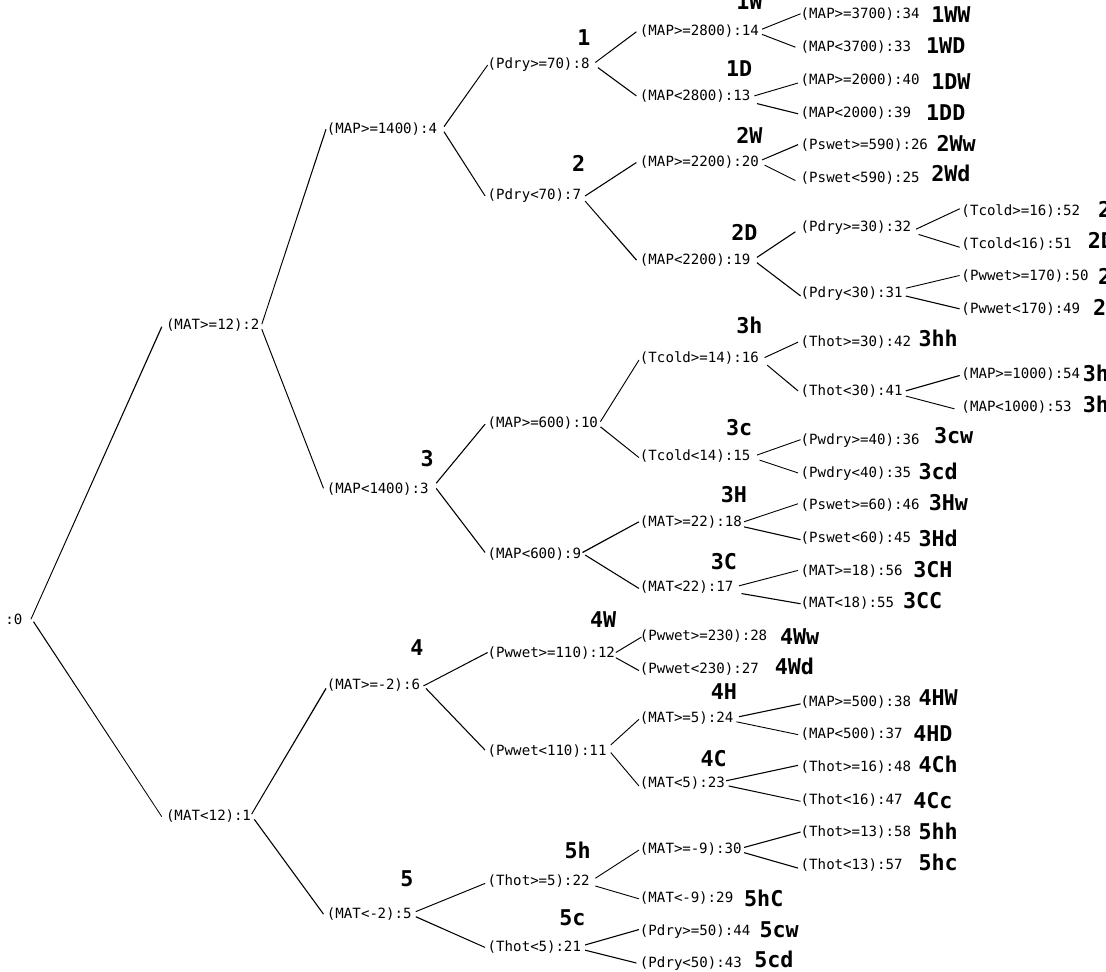
Fig. 1. Binary tree representation of the MRT climate classification rules. Climate variable names are given in Table 1. At each node, the decision rule is listed preceding the colon, while the order in which binary split was made is denoted by the integer value following the colon. Class names are given in bold. The 5 class level is assigned a number from 1–5. The 13 class and 30 class levels are denoted by adding letters to the numbers. If the rule immediately preceding the terminal node involves a precipitation variable, aW, w, D, or d is added, where the W or w indicates wetter conditions and the D or d indicates drier conditions. If the preceding rule involves a temperature variable, aH, h, C, or c is added, where the H or h indicates hotter conditions and the C or c indicates cooler conditions. Upper case letters are reserved for mean annual variables, whereas lower case letters are used for annual extreme or seasonal extreme variables. A map of class locations is given in Fig.